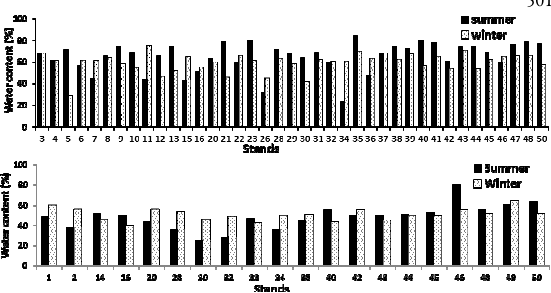
Fig. 4. Water content (%) of Zilla spinosa and Leptadenia pyrotechnica plants collected from different studied stands in Wadi El-Assiuty during summer and winter